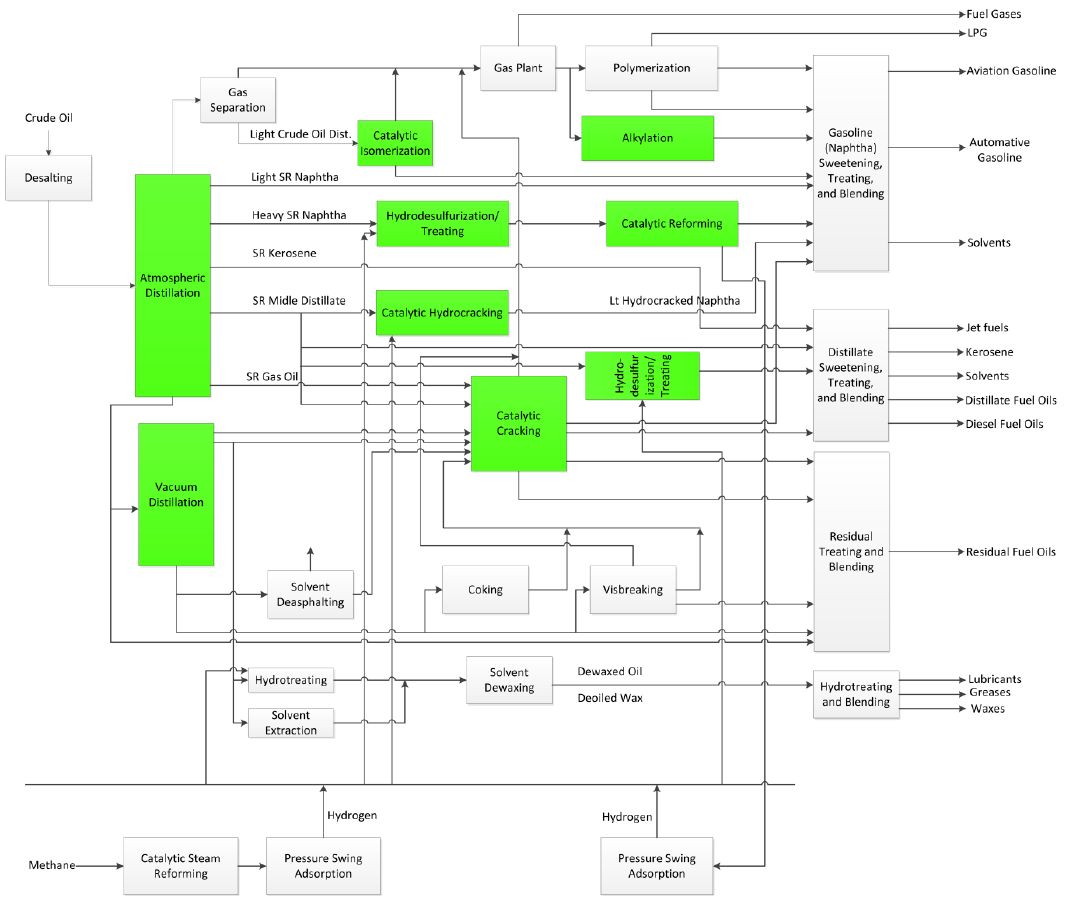
Figure 9. Process Flow Diagram of Modern Petroleum Refinery, adapted from [64].